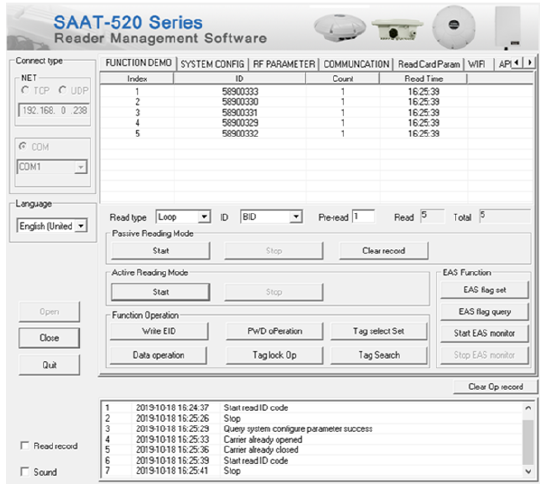
Fig. 6. RFID tags detected by